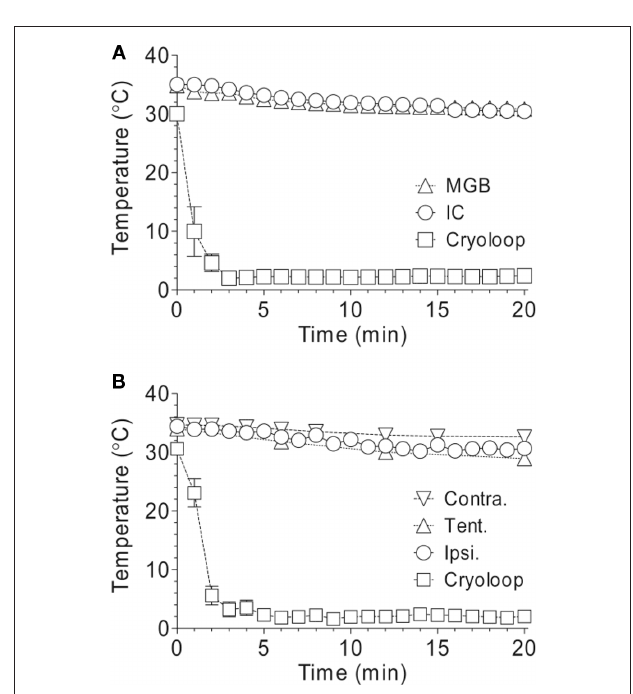
Figure 6 | Changes in temperature in subcortical auditory nuclei, ipsilateral and contralateral cochlea, and the tentorium. (A) Temperatures decreased by ∼ 4 ° C in the MGB and IC over a period of 20 min while the surface of auditory cortex was cooled to 2 ° C. (B) Temperatures decreased in the ipsilateral and contralateral cochlea by ∼ 2 and ∼ 4 ° C, respectively, and by ∼ 5 ° C at the tentorium, while the cortex